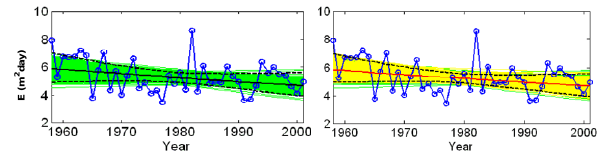
Fig. 3. Examples of evolution of annual mean of storm energy con- Figure 3. Examples of evolution of annual mean of storm energy content in all directions 2 tent in all directions (Node 2, see Fig. 1). Blue: time series. Black: (Node 2). Blue: time series. Black: linear regression trend. Red: Bayesian mean trend. Green: 3 linear regression trend. Red: Bayesian mean trend. Green: boot- bootstrapped samples. Yellow: Bayesian posterior samples. 4 strapped samples. Yellow: Bayesian posterior